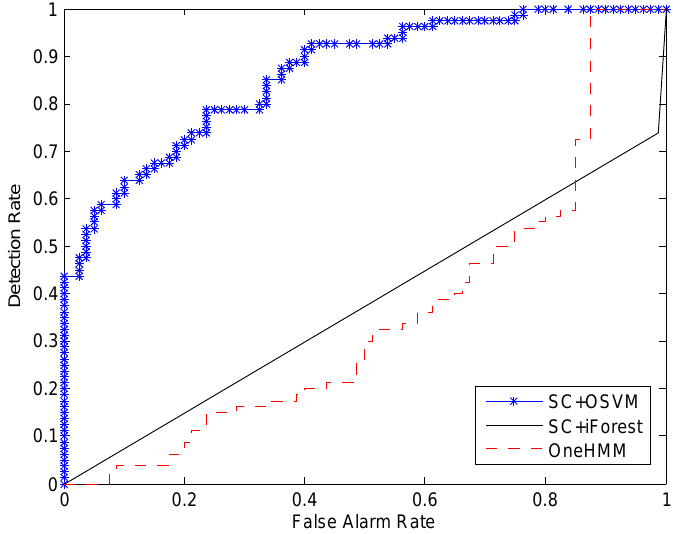
Figure 7. Comparison of the detection rate and the false alarm rate versus different numbers of training samples: training on 240 normal